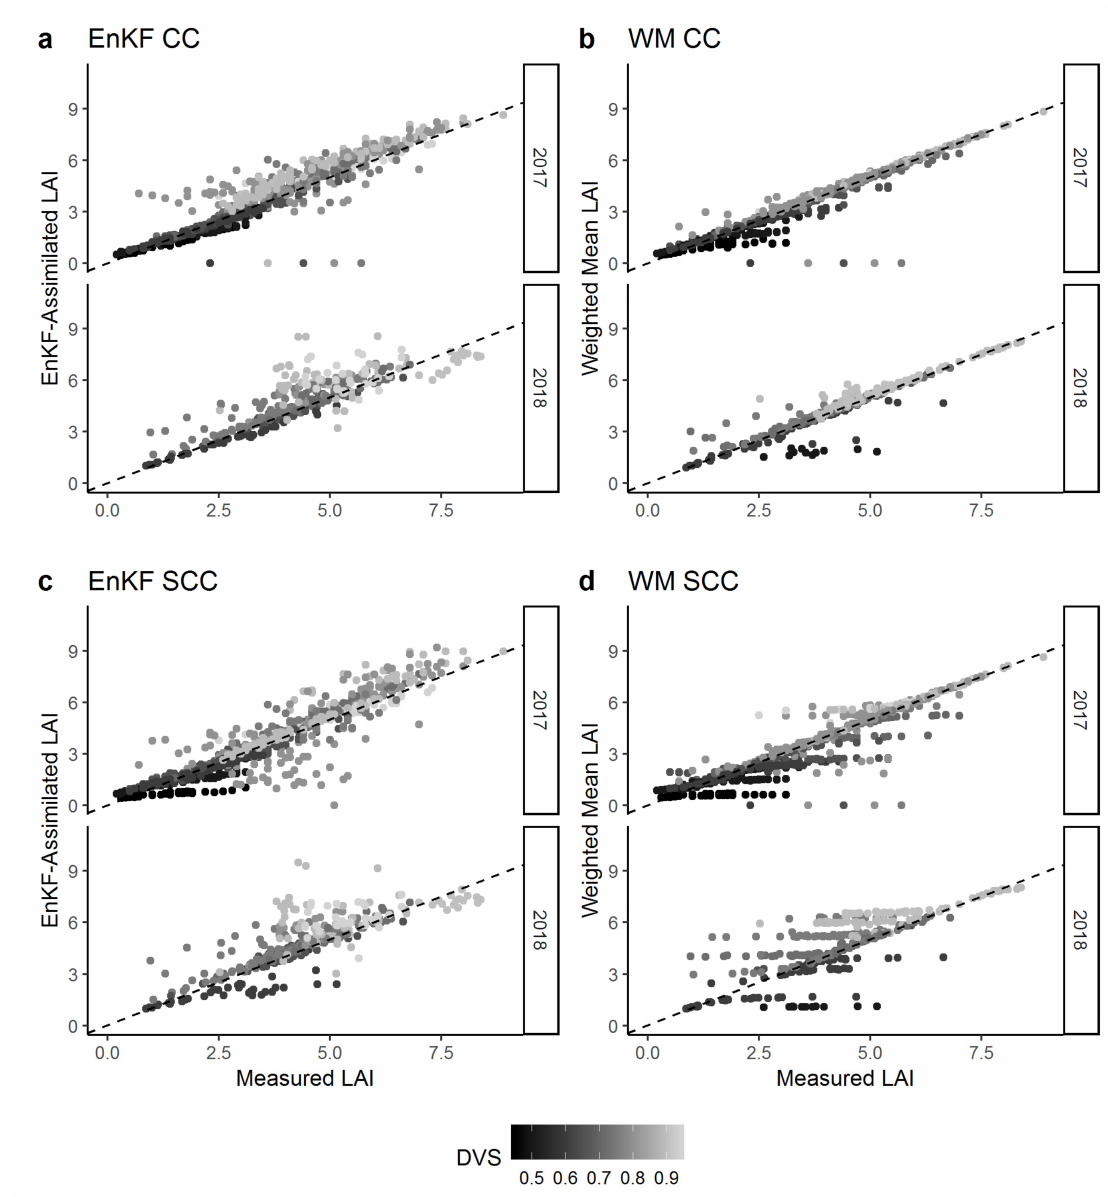
Figure A1. 1:1 plots showing measured LAI vs. simulated LAI for the EnKF-CC ( a ), WM-CC ( b ), EnKF-SCC ( c ) and WM-SCC ( d ) approaches for seven sites in 2016 / 2017 and seven sites in 2017 / 2018. The dashed line shows the 1:1 line. Color shown according to the estimated development stage of the plants at the time of the LAI measurement. DVS 0.01: Emergence, 0.45: beginning of stem elongation, 1: full flowering. EnKF: Ensemble Kalman Filter, WM: Weighted Mean, CC: Crop Component Set, SCC: Soil and Crop Component